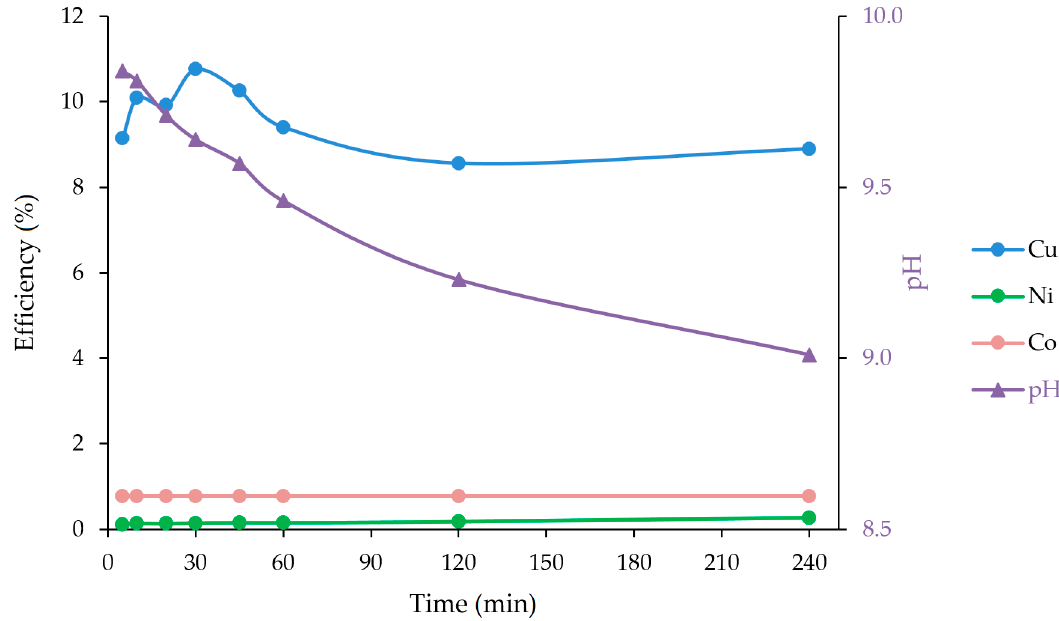
Figure 4. Kinetics of metals extraction during ammoniacal leaching with ultrasound at room temperature. During ultrasonic ammoniacal leaching at 50 ◦ C, the extraction efficiencies of copper and nickel were higher than at room temperature, and the amount of cobalt again was minimal (Table 6, Figure 5). It can be deduced from the table and graph that the concentrations of copper and nickel increased almost linearly with the leaching time. Table 6. Metals concentration and extraction efficiency of ammoniacal leaching with ultrasound at 50 ◦ C. Concentration Time (mg/L) (min)